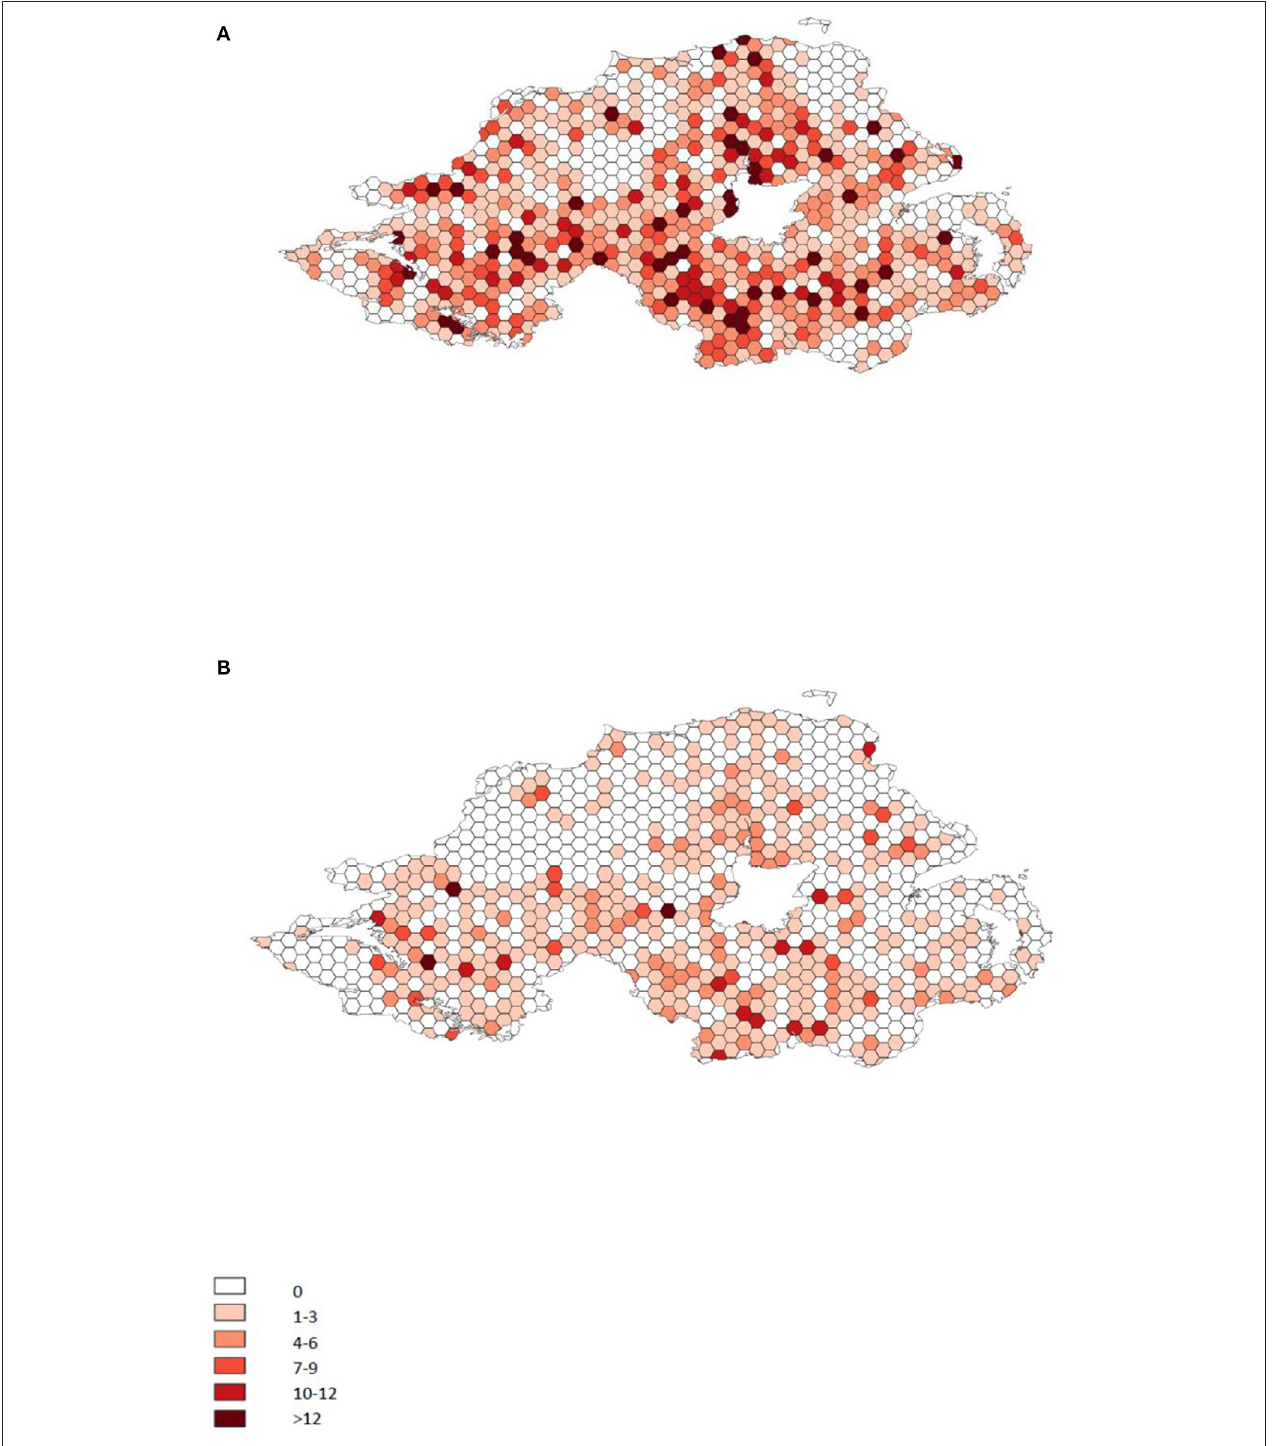
FIGURE 1 | The distribution of disclosed infection across Northern Ireland during 2017 (A) and 2020 (B) . Hexagons represent an area of ∼ 15 km 2 . Colours represent the number of animals disclosed as BVDP in that area for each year.